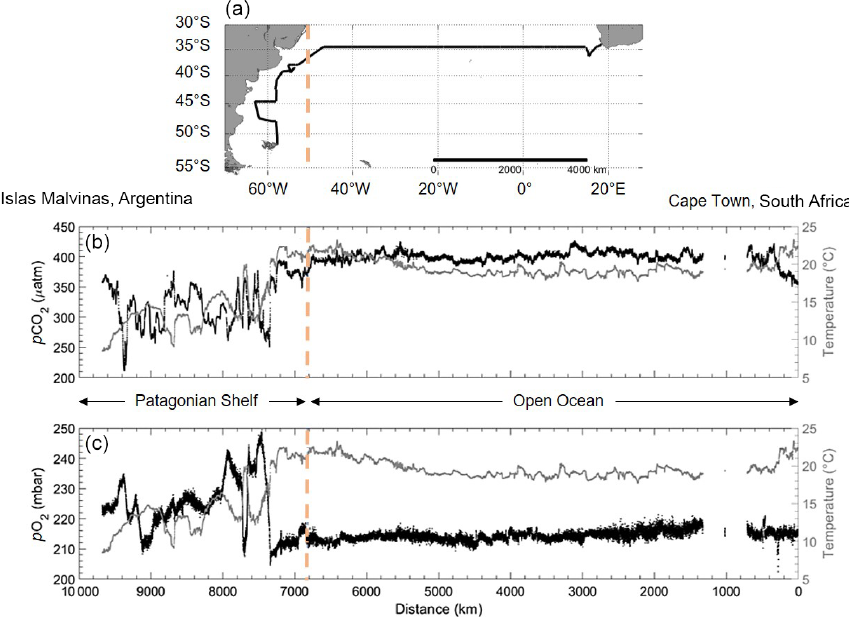
Figure 13. Data from the RV Meteor cruise M133 across the Atlantic Ocean (Cape Town, South Africa, to Islas Malvinas, Argentina). (a) Map of the cruise track (black line) across the Atlantic Ocean. The orange line shows the start of the cruise track entering the Patagonian Shelf. (b) p CO 2 (in µatm; black points) and (c) p O 2 (in mbar; black points), with water temperature (in ◦ C; grey line). Note the inverted x axis that coincides with the direction on the map. The Patagonian Shelf area (left of the orange dashed line) and open ocean (right of the orange dashed line) are also indicated.